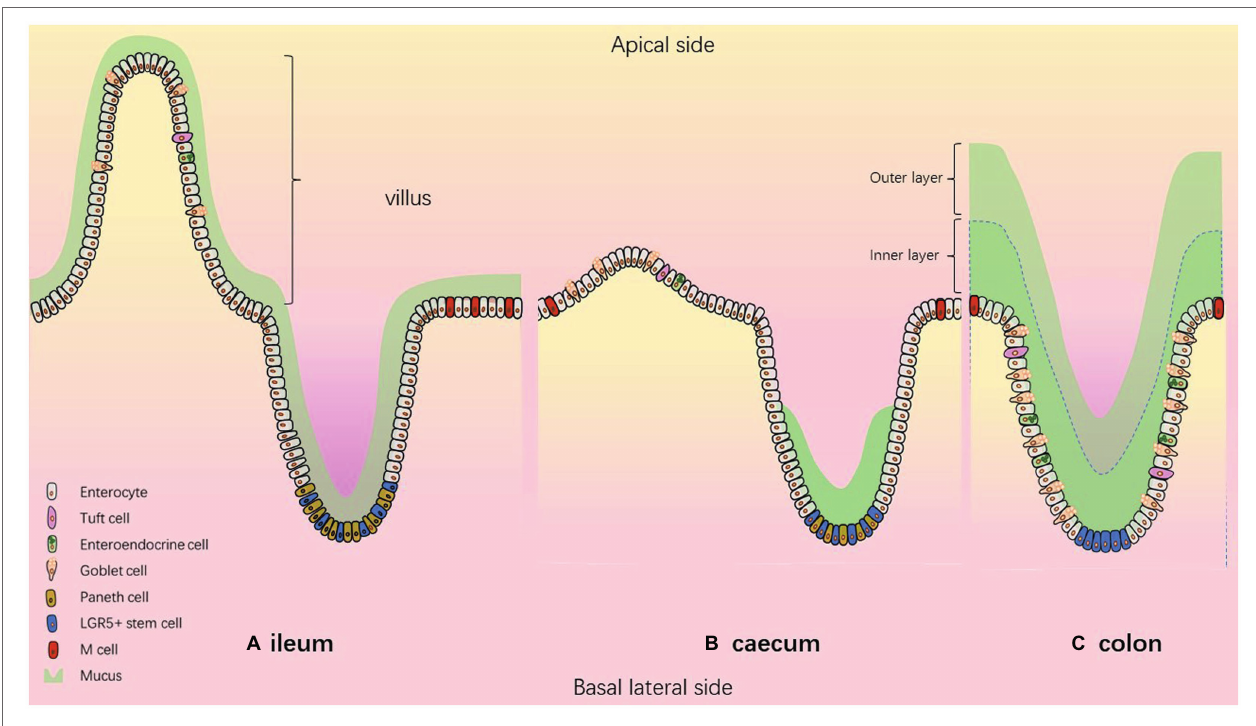
FIGURE 1 | The composition of the intestinal epithelium according to the segment. Model describing (A) ileum (B) caecum (C)